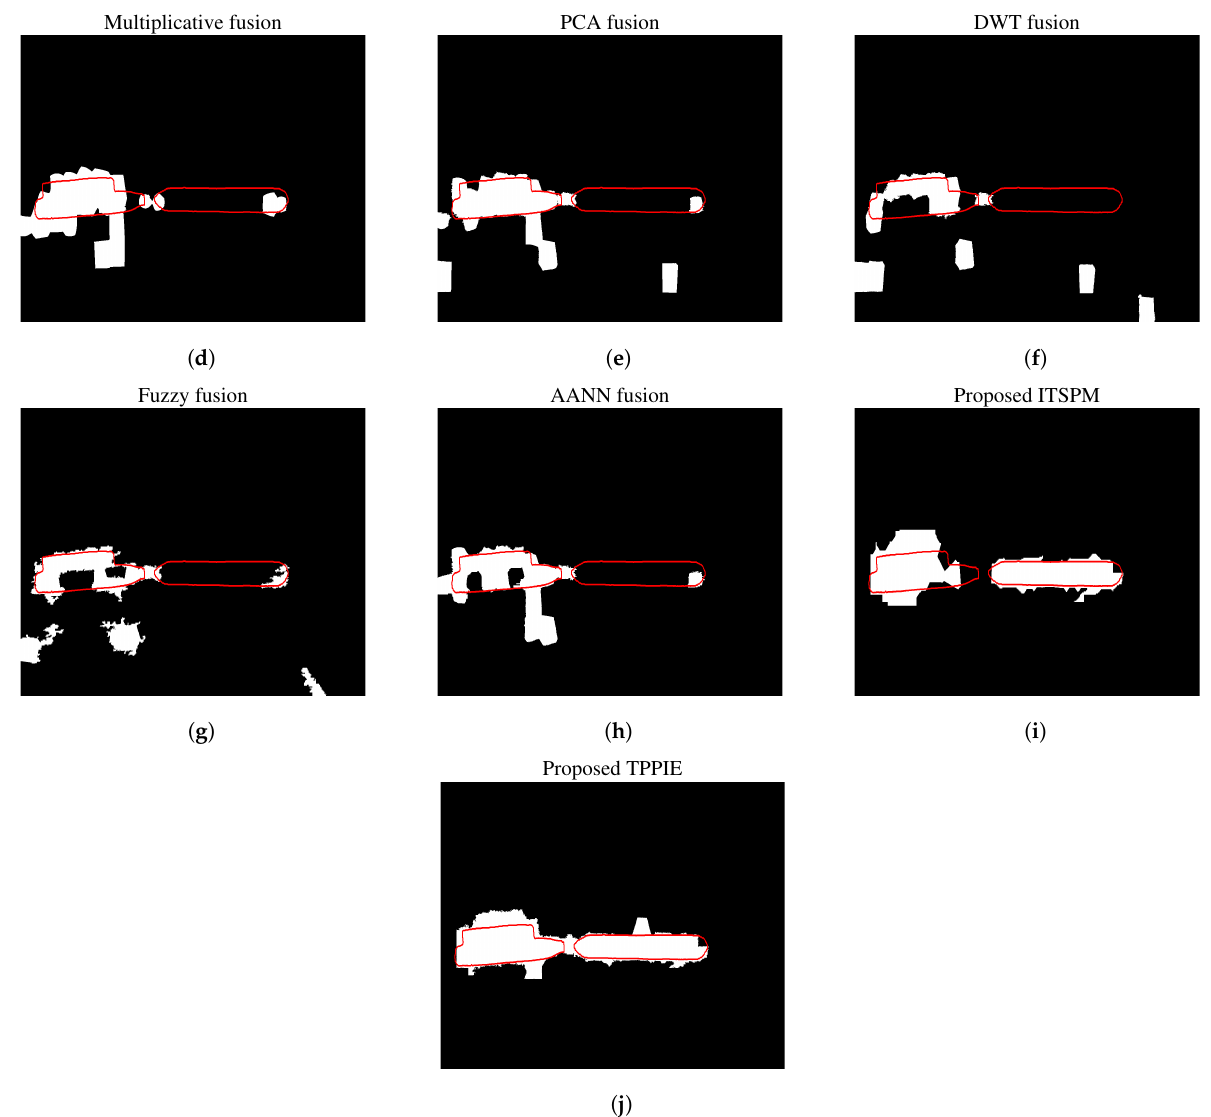
Figure 9. Superpixel-based detection results of different methods for Experimental Scene 1 with respect to PFA = 0.03: ( a ) Spaceborne image processing (PD = 0.0804); ( b ) airborne image processing (PD = 0.4549); ( c ) additive fusion [10] (PD = 0.4191); ( d ) multiplicative fusion [10] (PD = 0.5464); ( e ) PCA fusion [12] (PD = 0.5356); ( f ) DWT fusion [13] (PD = 0.3249); ( g ) fuzzy fusion [16] (PD = 0.4314); ( h ) AANN fusion [18] (PD = 0.4704); ( i ) proposed ITSPM fusion (PD = 0.8956); and ( j ) proposed TPPIE fusion (PD = 0.9853 ). The red lines denote the boundaries of target vessels. The proposed TPPIE fusion method had the best detection